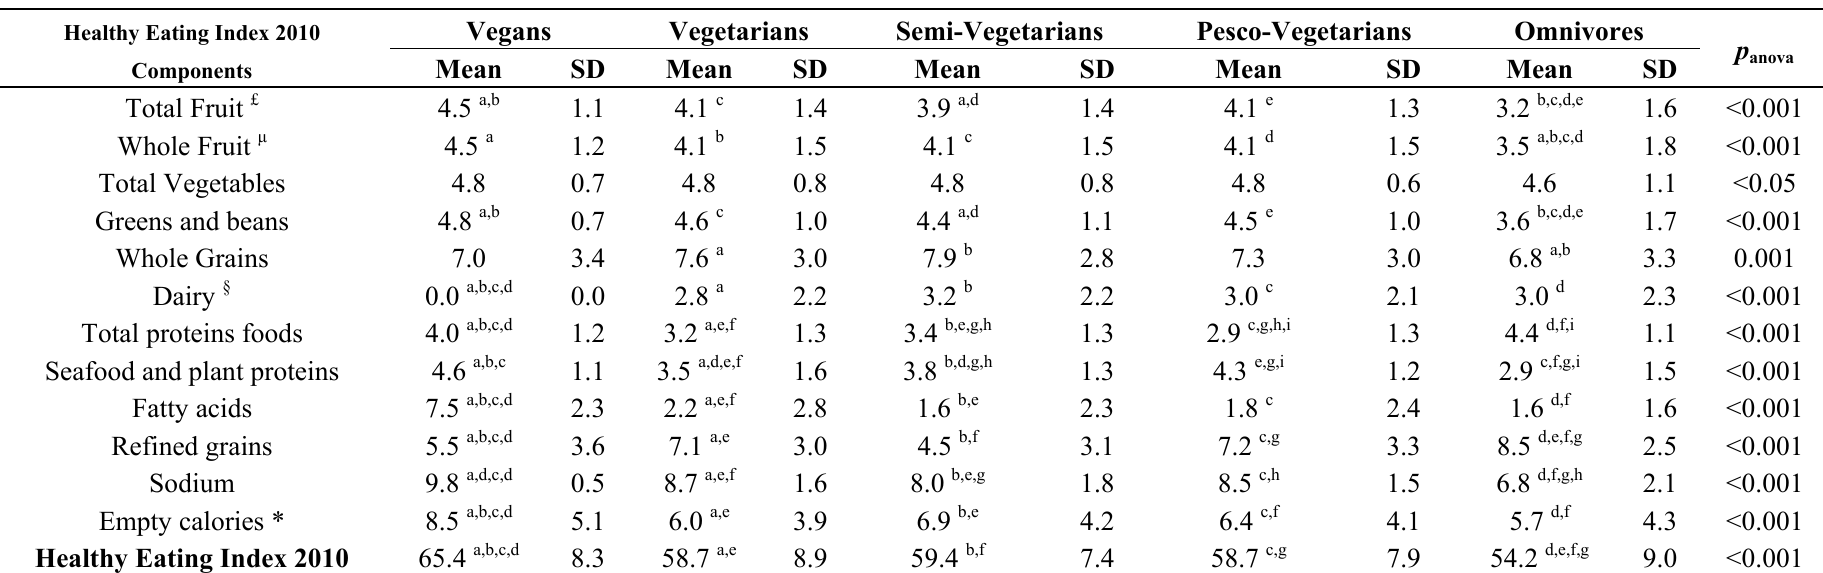
Table 3. Total and component scores for Healthy Eating Index 2010 ( n = 1475)